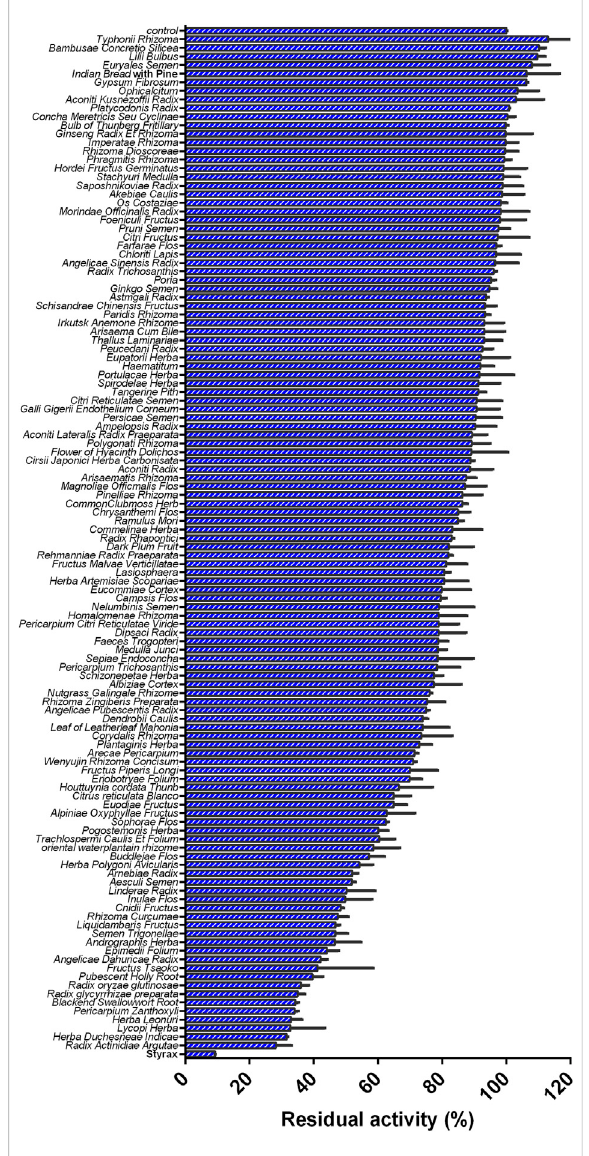
FIGURE 1 Inhibition effects of 119 Chinese medicine